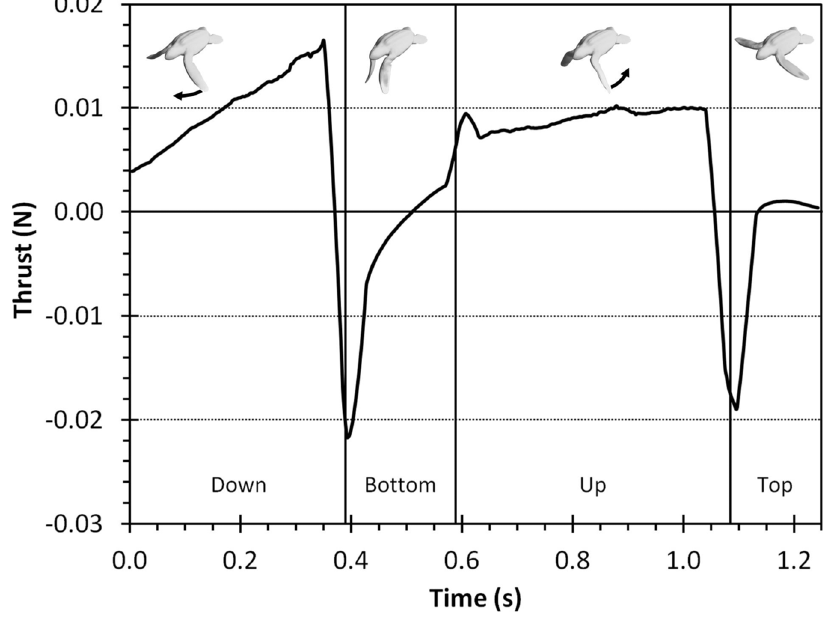
Figure 4. The thrust produced by our simulated neonate turtle as it goes through one stroke period. The vertical black lines demark the four different stroke phases (down, bottom, up, and top). The images at the top are clips from each respective phase.